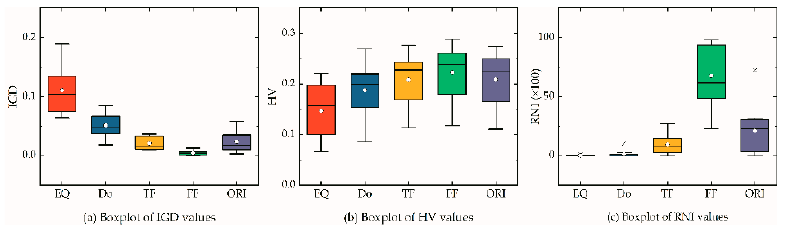
Figure 5. Boxplot of IGD, HV, and RNI values of each area size.